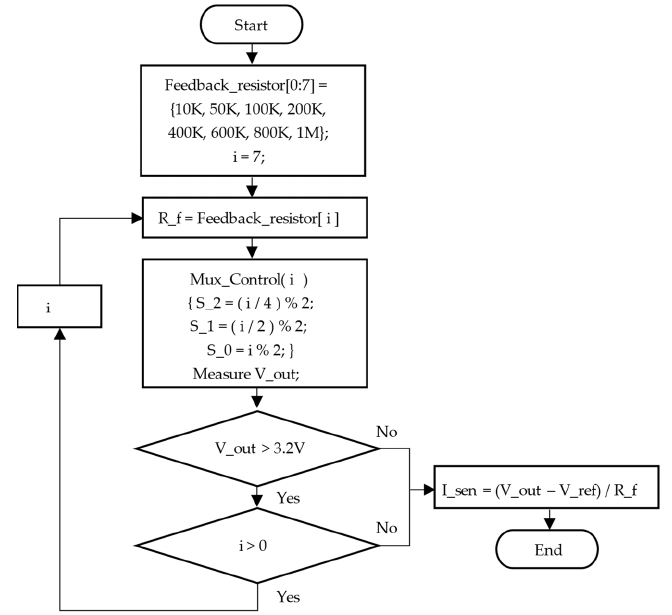
Figure 12. Firmware flowchart embedded in the Microcontroller Unit (MCU).